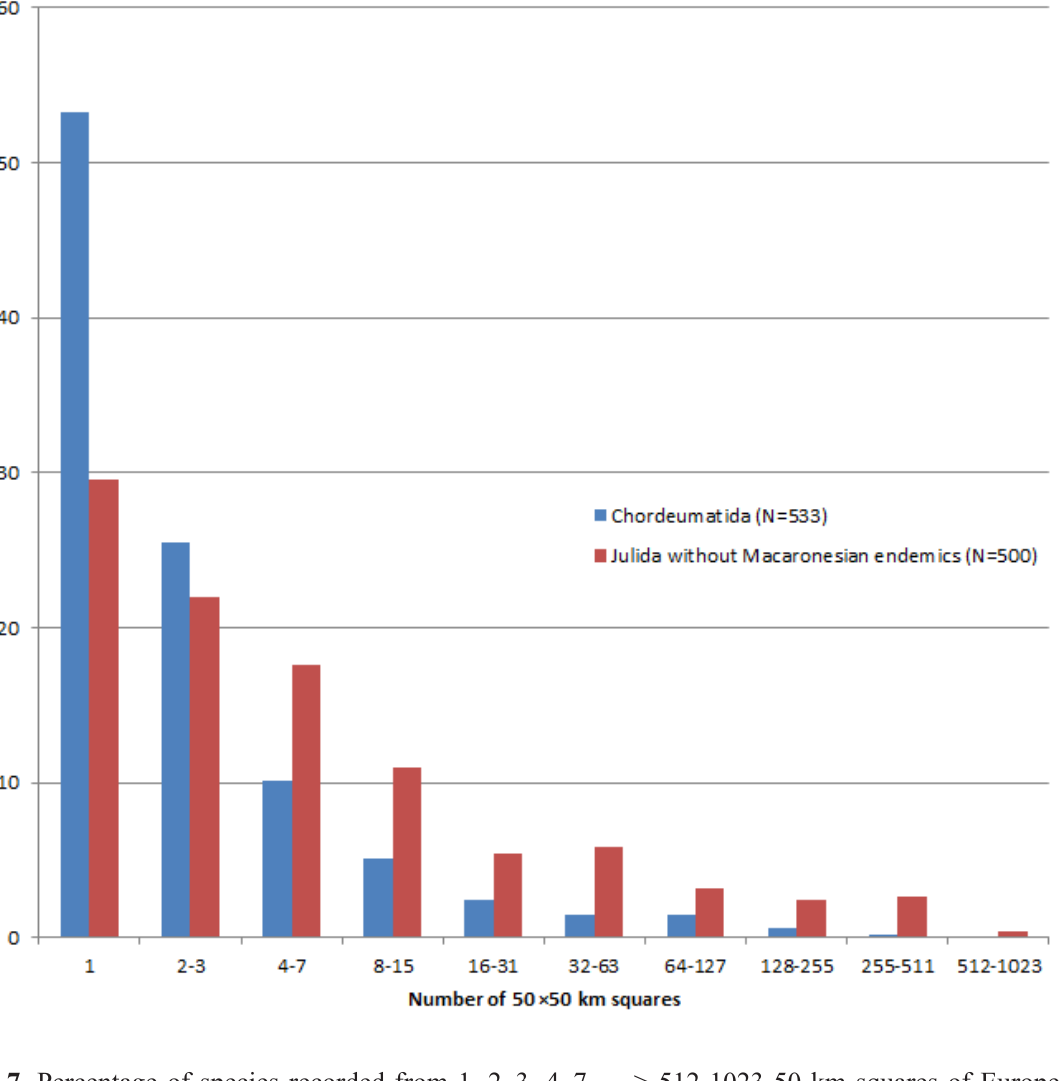
Fig. 7. Percentage of species recorded from 1, 2–3, 4–7 … > 512-1023 50 km squares of European Chordeumatida C.L. Koch, 1847 (blue columns) and Julida Brandt, 1833 without Macaronesian endemics (red columns, data from Kime & Enghoff